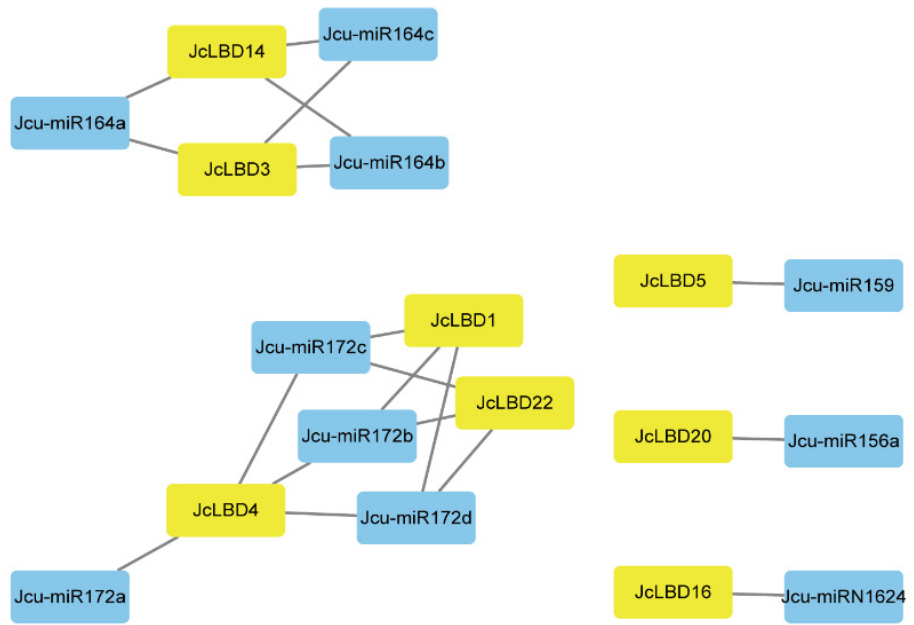
Figure 4. Netwrok between the Jcu-miRNAs and their targeted JcLBD genes. The blue and yellow rectangles indicate miRNAs and target genes, respectively.